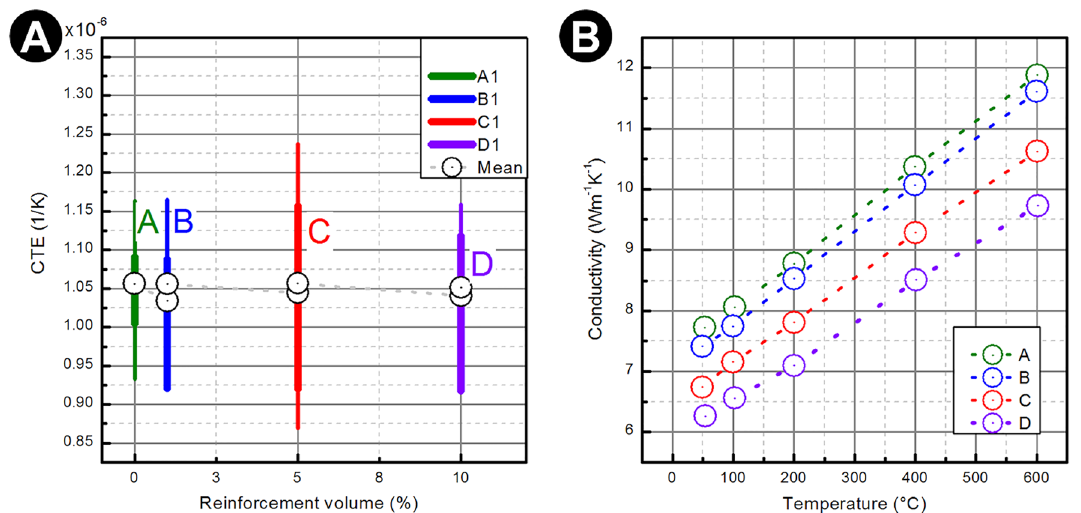
Figure 5. ( A ) The coefficient of the thermal expansion of the sintered Ti5Al4V alloy composites with and without biogenic filler. ( B ) The thermal conductivity as a function of temperature for sintered Ti6Al4V alloy composite with and without biogenic filler. Series: A—0%, B—1%, C—5%,